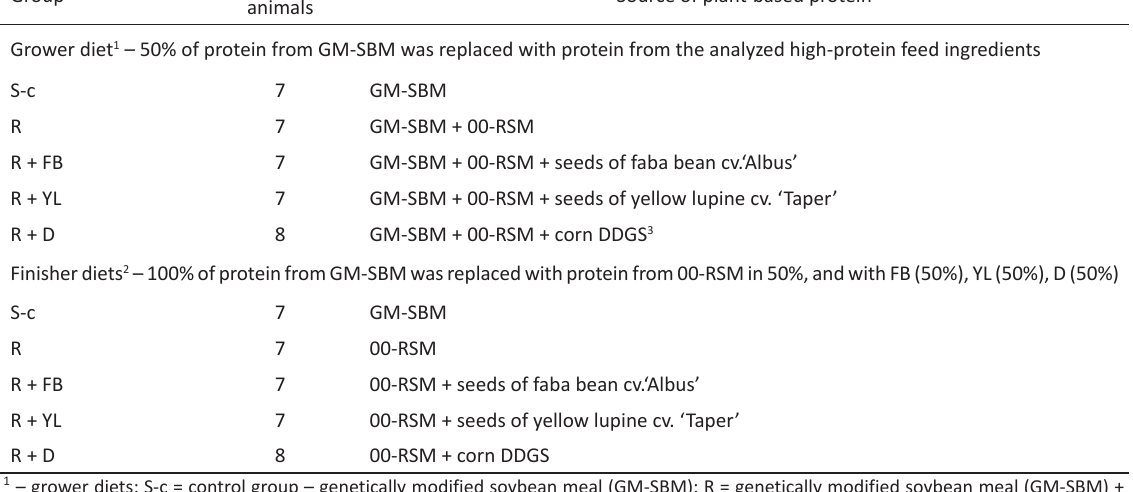
Source of plant-based protein